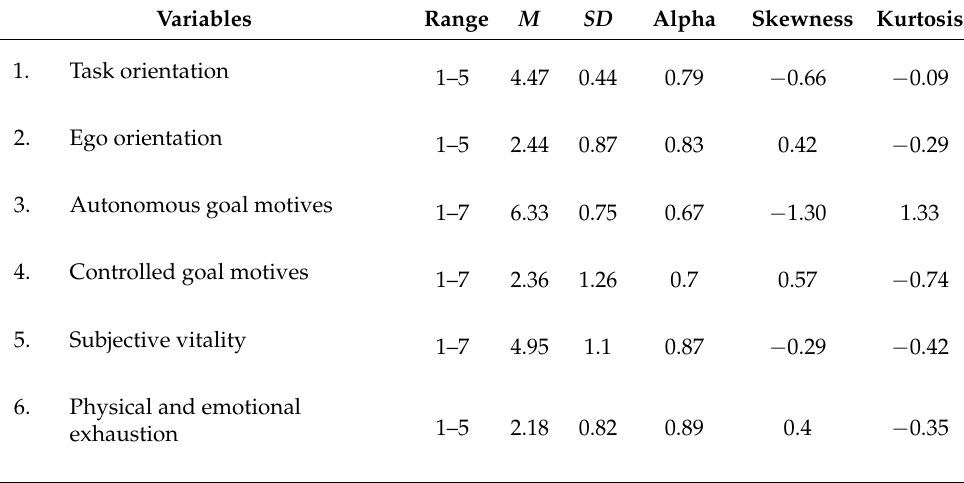
Table 1. Descriptive statistics and